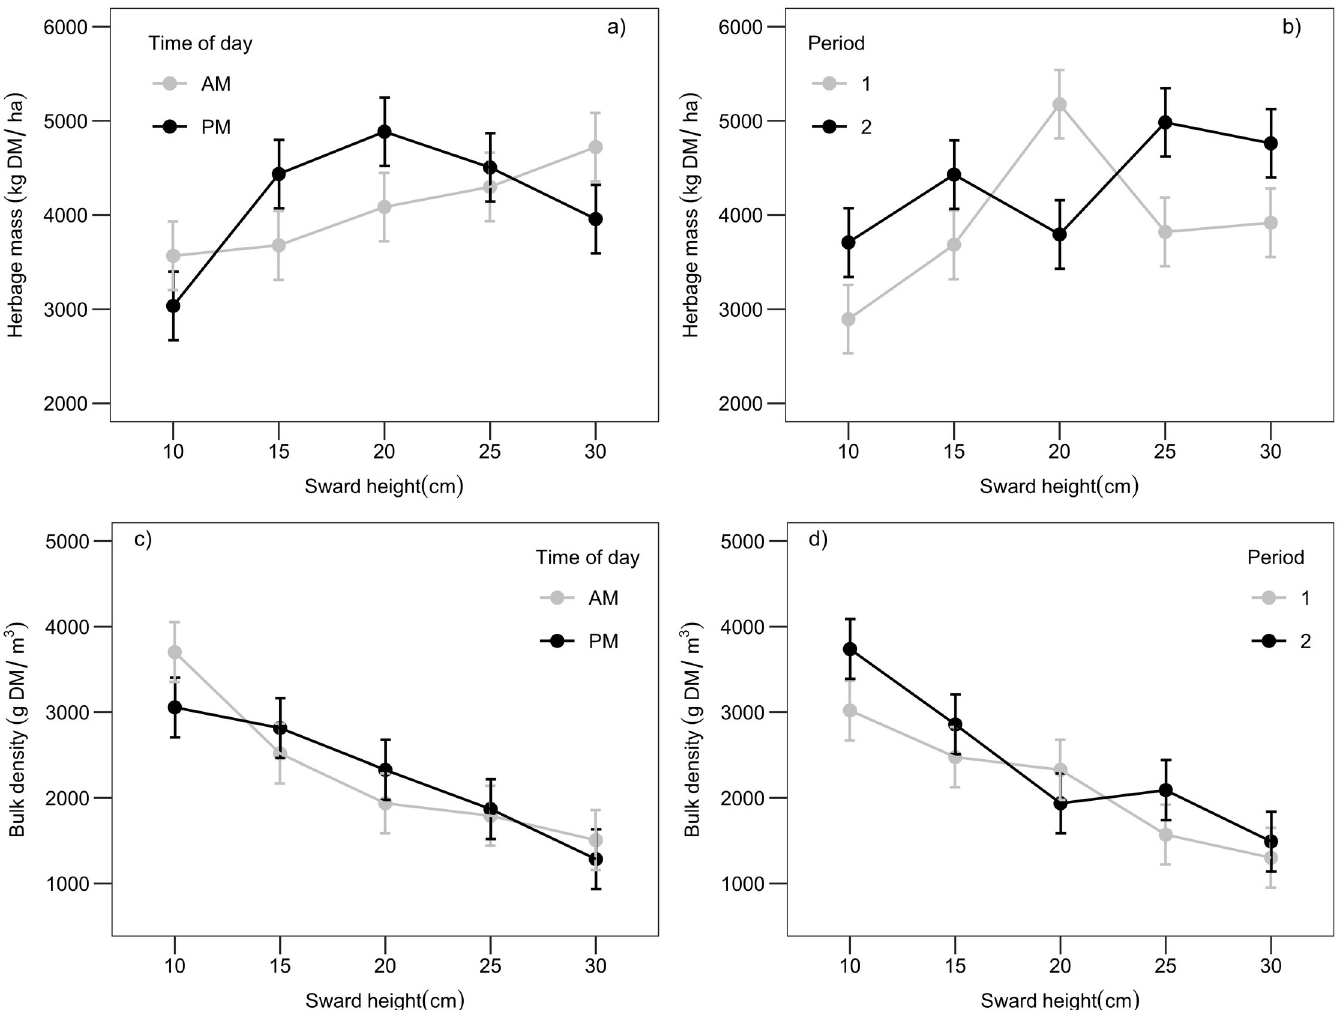
Fig 1. Interactions between sward heights of Kikuyu grass and time of day and period of evaluation. Interactions between sward heights (10, 15, 20, 25, and 30 cm) of Kikuyu grass ( Cenchrus clandestinus— Hochst. ex Chiov) and time of day (morning, AM, and afternoon, PM) on herbage mass (a) and bulk density (c), and interactions between sward heights and period of evaluation (1 and 2) on herbage mass (b) and bulk density (d). The bars represent the standard errors of the mean.